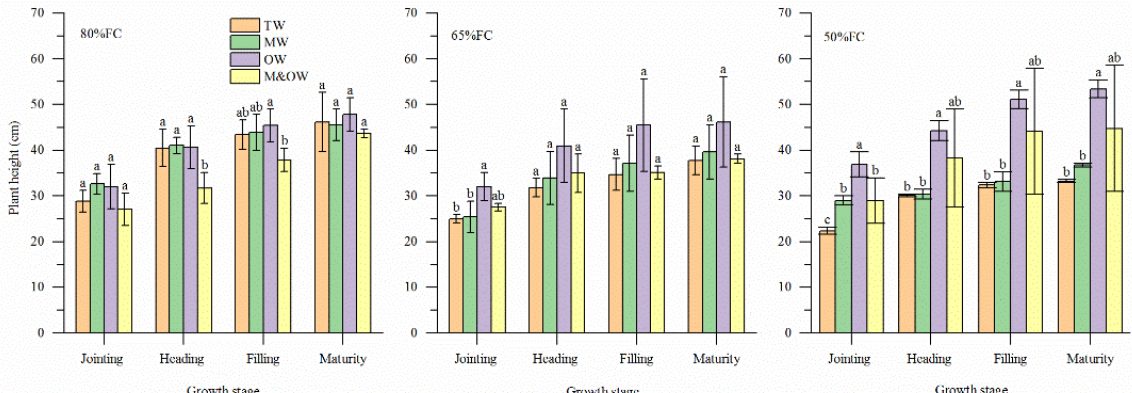
Figure 2. Effect of tap water (TW), magnetized water (MW), oxygenated water (OW), and magnetized and oxygenated water (M&OW) irrigation on plant height of winter wheat with 80%FC, 65%FC, and 50%FC irrigation amounts in the different growth stages. Different letters above the bars indicate significant differences among treatments in the different growth stages at p < 0.05. The error bars indicate standard deviations.